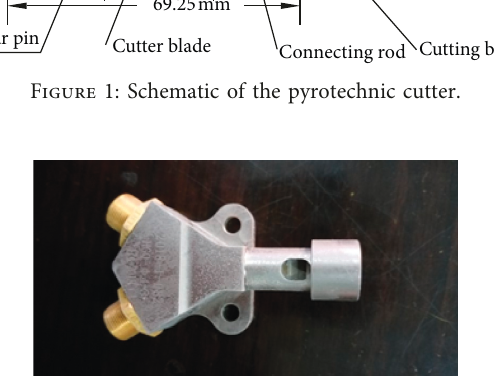
Figure 2: Real pyrotechnic